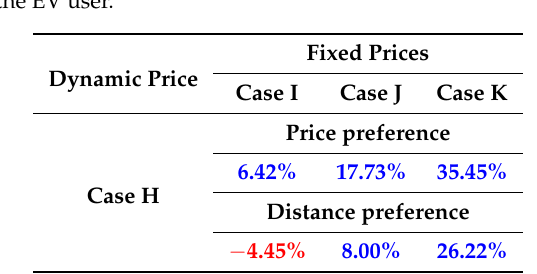
Table 13. Average charge price differences between dynamic Case H and the homologous fixed cases. The average prices paid by the EV users when Case H was used were 0.1877 e /kWh and 0.2180 e /kWh for the user price preference scenario and the user distance preference scenario, respectively. Blue color means that Case H was advantageous for the EV user, whereas the red color means that Case H was not advantageous for the EV user.